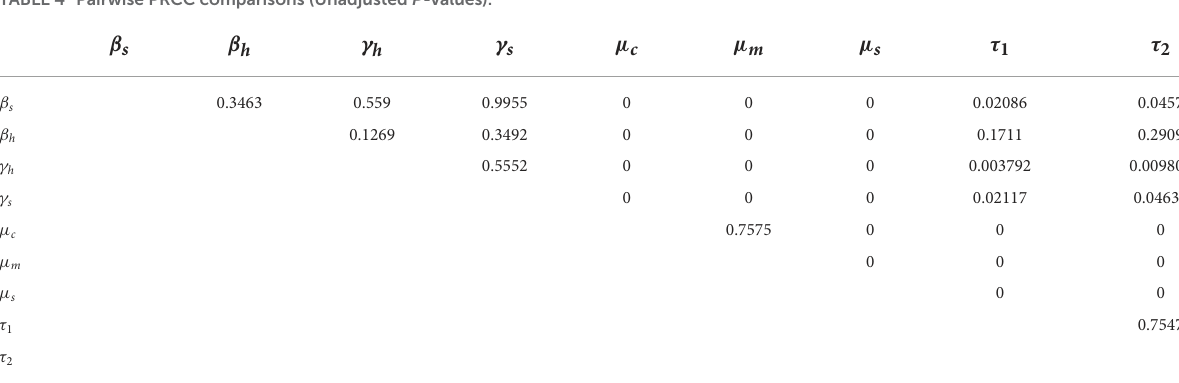
TABLE 4 Pairwise PRCC comparisons (Unadjusted P -values).